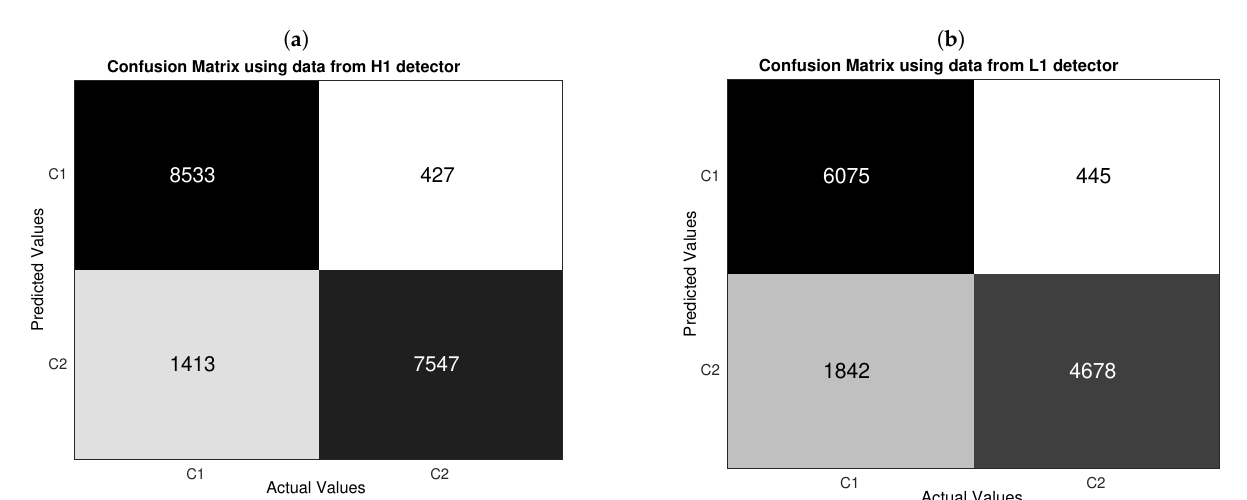
Figure 9. Confusion matrices computed from the testing. C 1 is the label for noise only and C 2 the label for noise plus GW injection. Our CNN has 32 kernels and 3 stacks when is run with H1 data, and 16 kernels and 2 stacks when is run with L1 data. Time resolution is T win = 0.75 s. Working with H1 data, 8533/ ( 8533 + 427 ) 0.952 predicitions for C 1 are correct and 1413/ ( 8533 + 1413 ) 0.142 predictions for C 2 are incorrect and, working L1 data, 6075/ ( 6075 + 445 ) 0.932 predicitions for C 1 are correct and 1842/ ( 6075 + 1842 ) 0.233 predictions for C 2 are incorrect. These results show that our CNN very precisely classifies noise samples at the cost of reaching a not less number of false GW